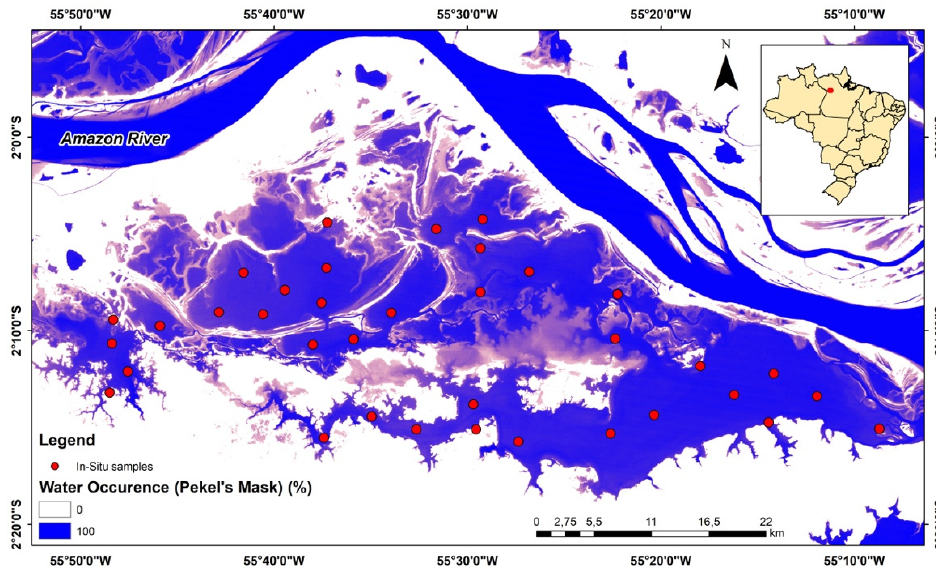
Figure 2. Study Area of the Curuai floodplain lake system.